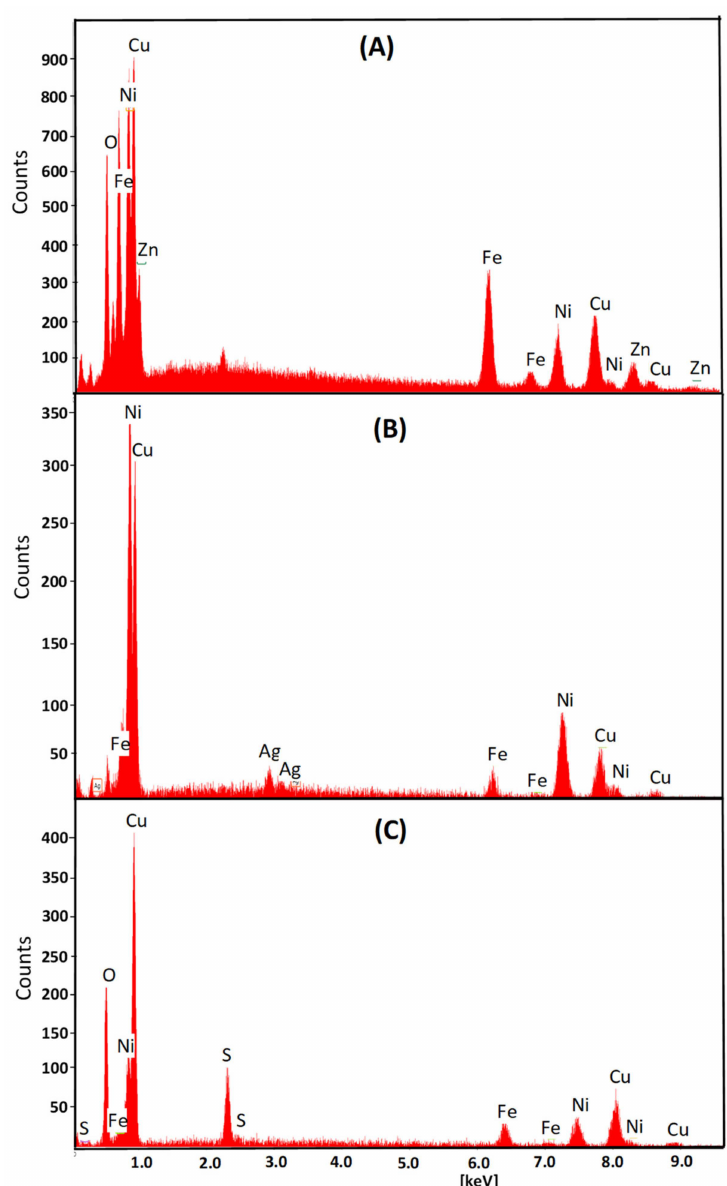
Figure 3. An example EDX spectra of the deposited FeNi films on different substrates ( A ) brass, ( B ) silver, and ( C ) aluminum, in the presence of II external magnetic field orientation in respect to surface